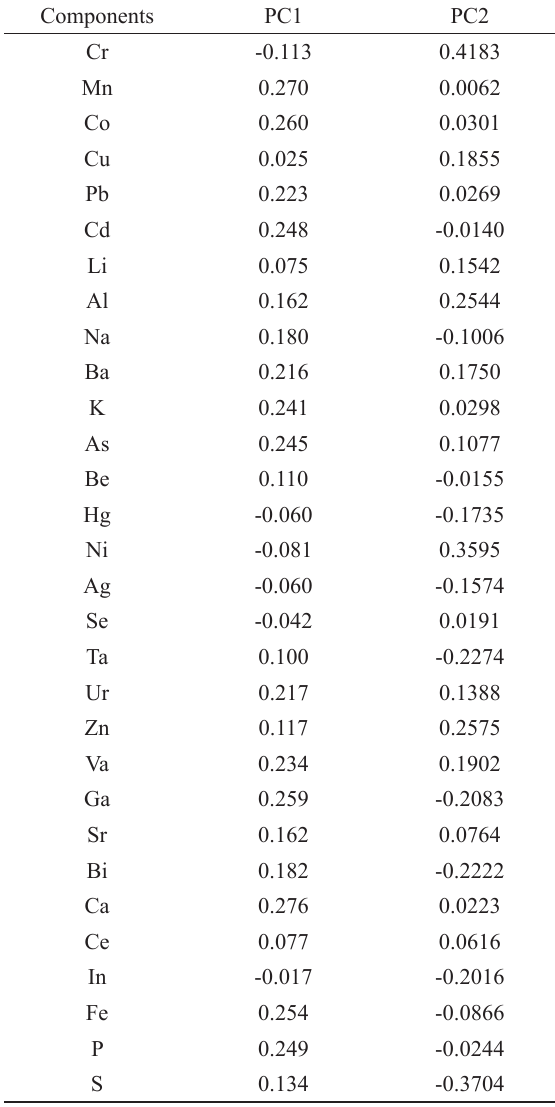
Data for principal components 1 and 2 of the water analysis